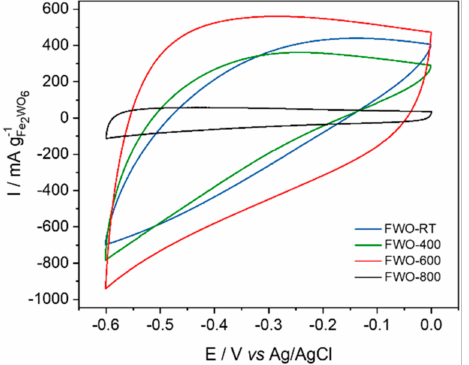
Figure 2. Cyclic voltammograms of the samples FWO-RT, FWO-400, FWO-600 and FWO-800 at